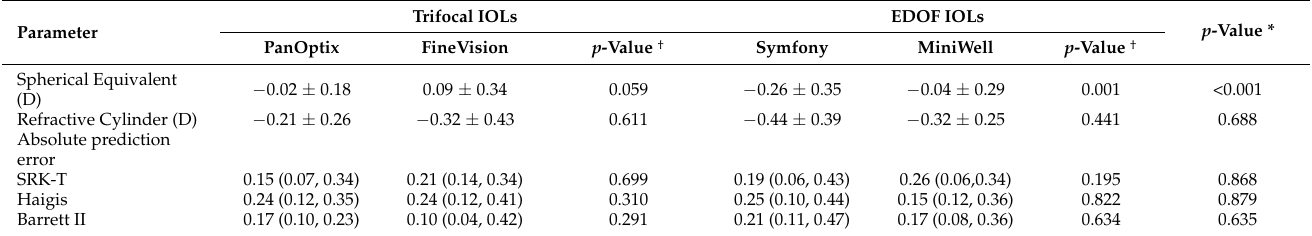
Figure 2. Distant-corrected binocular defocus curves with PanOptix, FineVision, Symfony, and MiniWell. PanOptix, FineVision, and MiniWell maintained visual acuity above 0.10 logMAR at the defocus power of −2 .5 D, whereas Symfony presented with narrower depth of focus than the other IOLs. Symfony and MiniWell provided better visual acuity at the defocus power of −0 .5 D and −1 .0 D, and MiniWell presented with more extended defocus curve than Symfony. Table 2. Refractive outcome and predictive error in the four IOL groups. Table 2. Refractive outcome and predictive error in the four IOL groups.